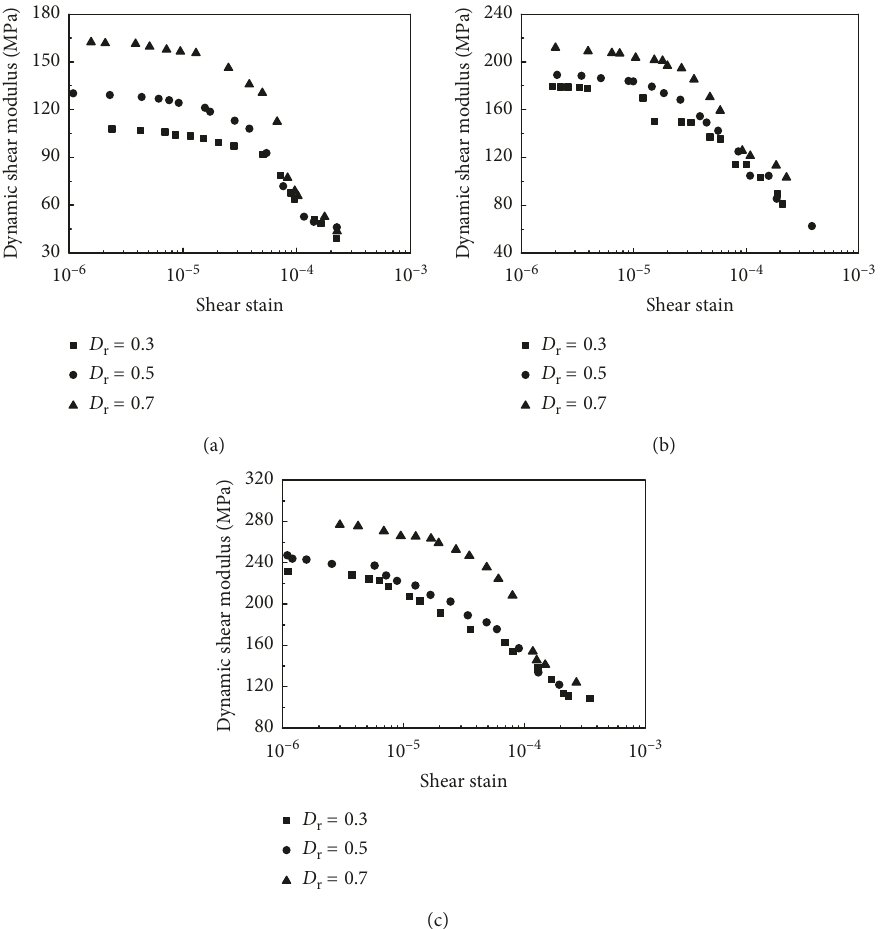
Figure 5: Effect of relative density on the G - c curve of steel slag: (a) σ � 100kPa; (b) σ � 200 kPa; (c) σ �